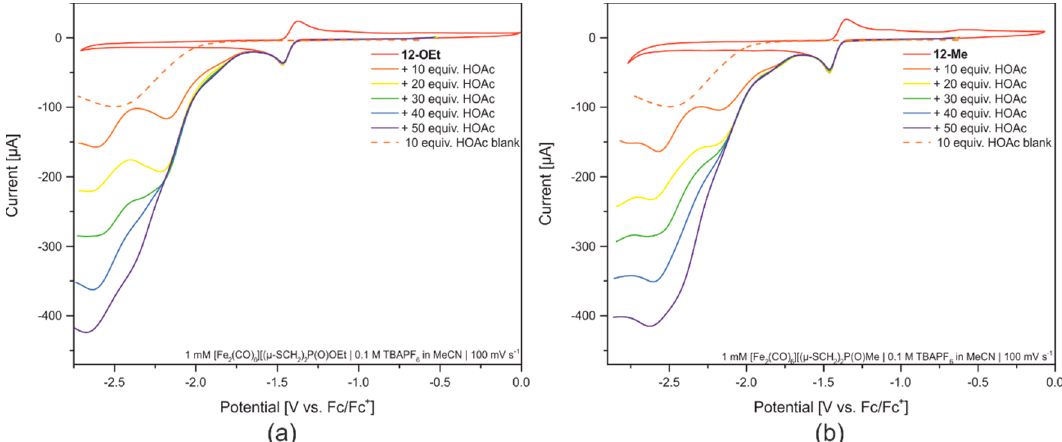
Figure 10. ( a ) CVs of 12-OEt ; ( b ) CVs of 12-Me. Both figures show CVs in presence of 0 to 50 equivalents of acetic acid (HOAc). Both measurements were performed using a three-electrode setup utilizing a glassy carbon as working electrode and platinum-and silver wires as counter- and pseudo-reference electrode, respectively. Both compounds were adjusted to their respective redox potential vs. Fc/Fc + and used as self-internal reference. Blank measurements were performed using Fc as internal reference.